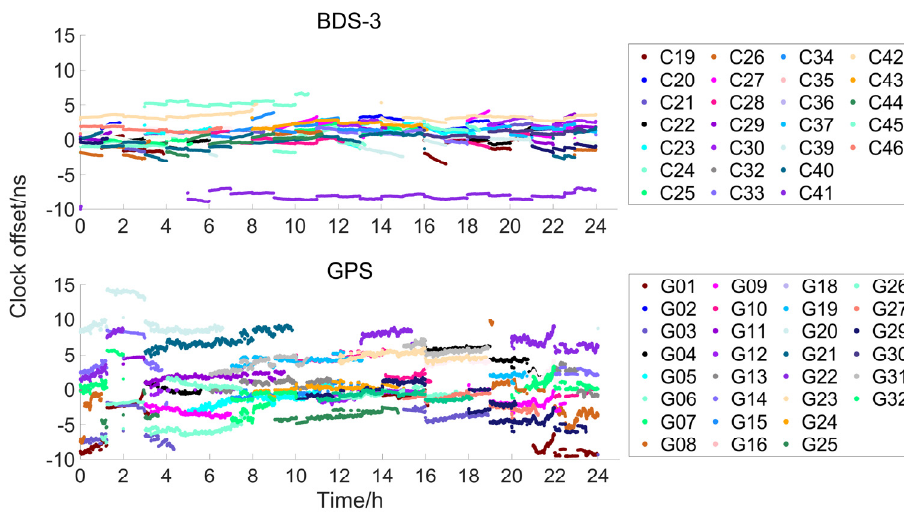
Figure 4. Time series of the clock corrections of the BDS-3 and the GPS satellites on DOY 192 in 2022.